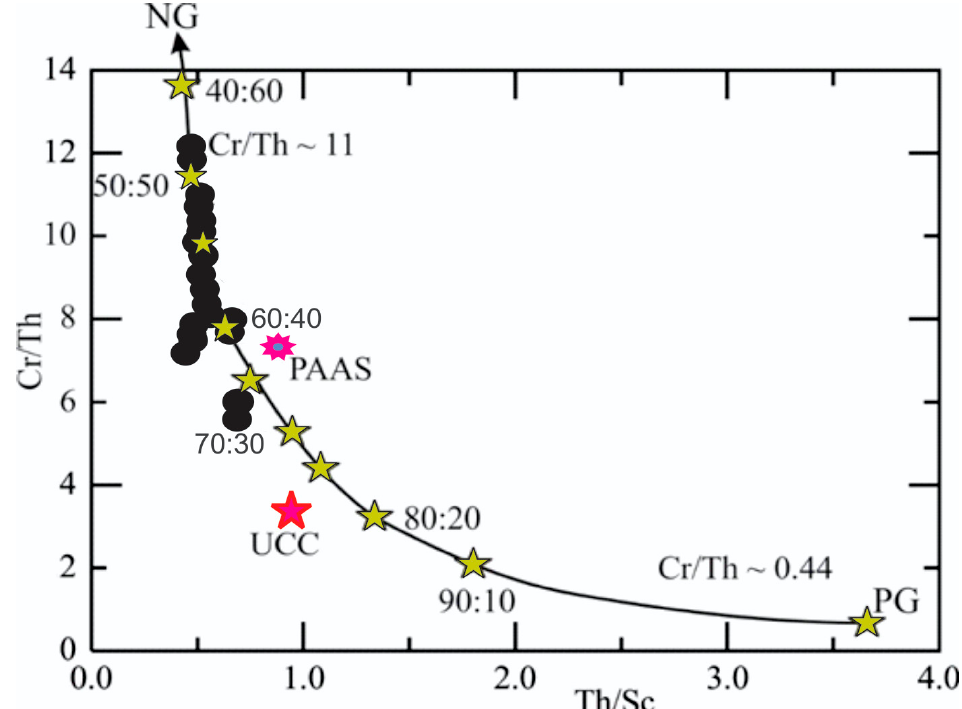
Figure 9. A Th/Sc versus Cr/Th plot for the Brahmaputra River sediments. The curved line represents the mixing curve between a mafic end member (NG) of average Nidar gabbro from the intra-oceanic tholeiitic arc, South Ladakh ophiolites (NW Himalaya, India) (NG, data from Maheo et al. [47]) and an average Phanerozoic granite (PG) (data from Condie [48]). Brahmaputra River sediment samples are represented by the black dots.